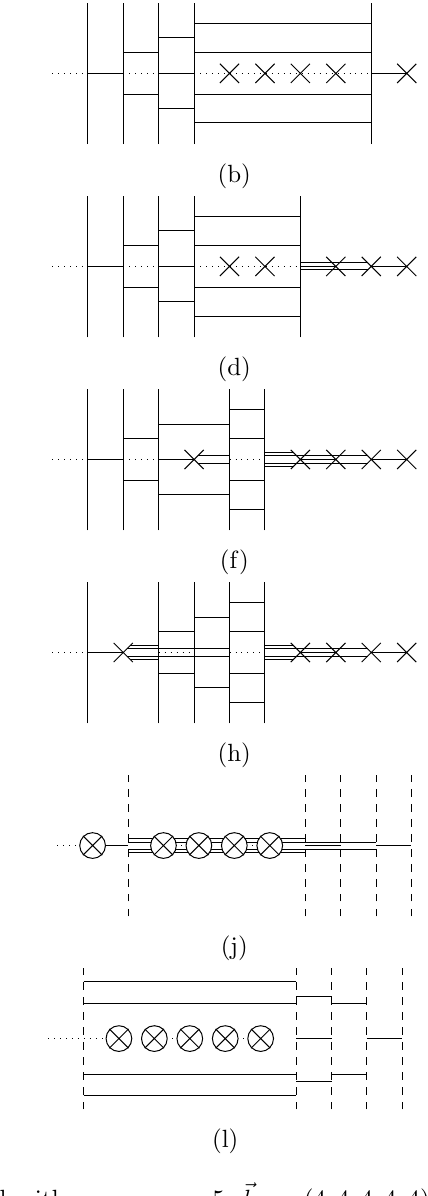
Figure 28. Higgsing of the orthosymplectic model with n s = n d = 5, ~l d = (4 ; 4 ; 4 ; 4 ; 4), ~l s = (0 ; 2 ; 0 ; 2 ; 0) and rightmost orientifold plane O 3 (cid:0) . (a) is the Coulomb branch. (b-j) are one step phase transitions where the linking numbers of the (cid:12)vebranes are kept constant by creating or not creating D3-branes after each transition. (k) Higgs branch before the collapse transition; the half NS5-branes have interval numbers ~ k 0 = (0 ; 1 ; 1 ; 1 ; 1). (l) Higgs branch after the collapse transition, s the half NS5-branes have interval numbers ~ k s = (1 ; 1 ; 1 ; 1 ;